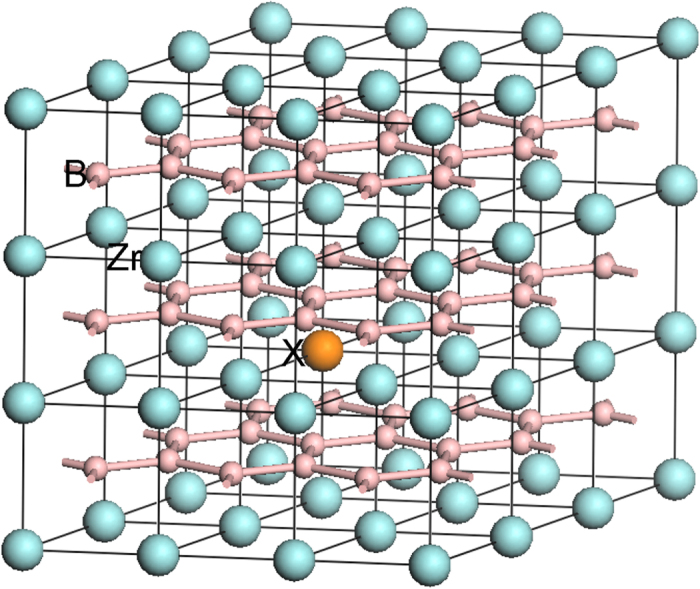
Illustration of a 3 × 3 × 3 ZrB2 supercell model with one Zr substituted by element X.